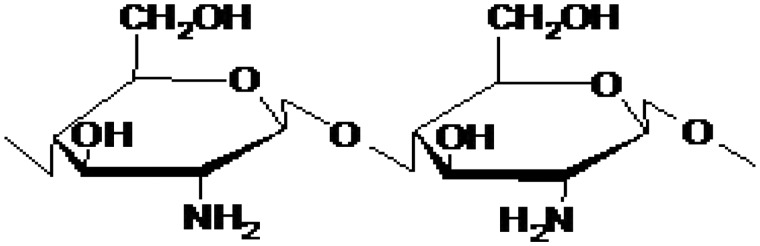
Chitosan structure